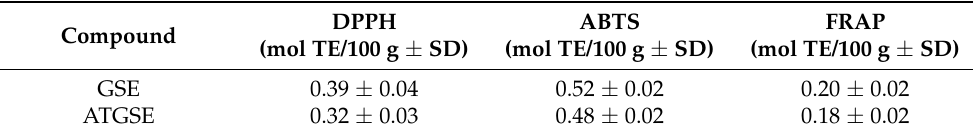
Table 1. Antioxidant activity of grape seed extract (GSE) and its alkalinized version (ATGSE) evalu- ated by DPPH, ABTS, and FRAP assays.